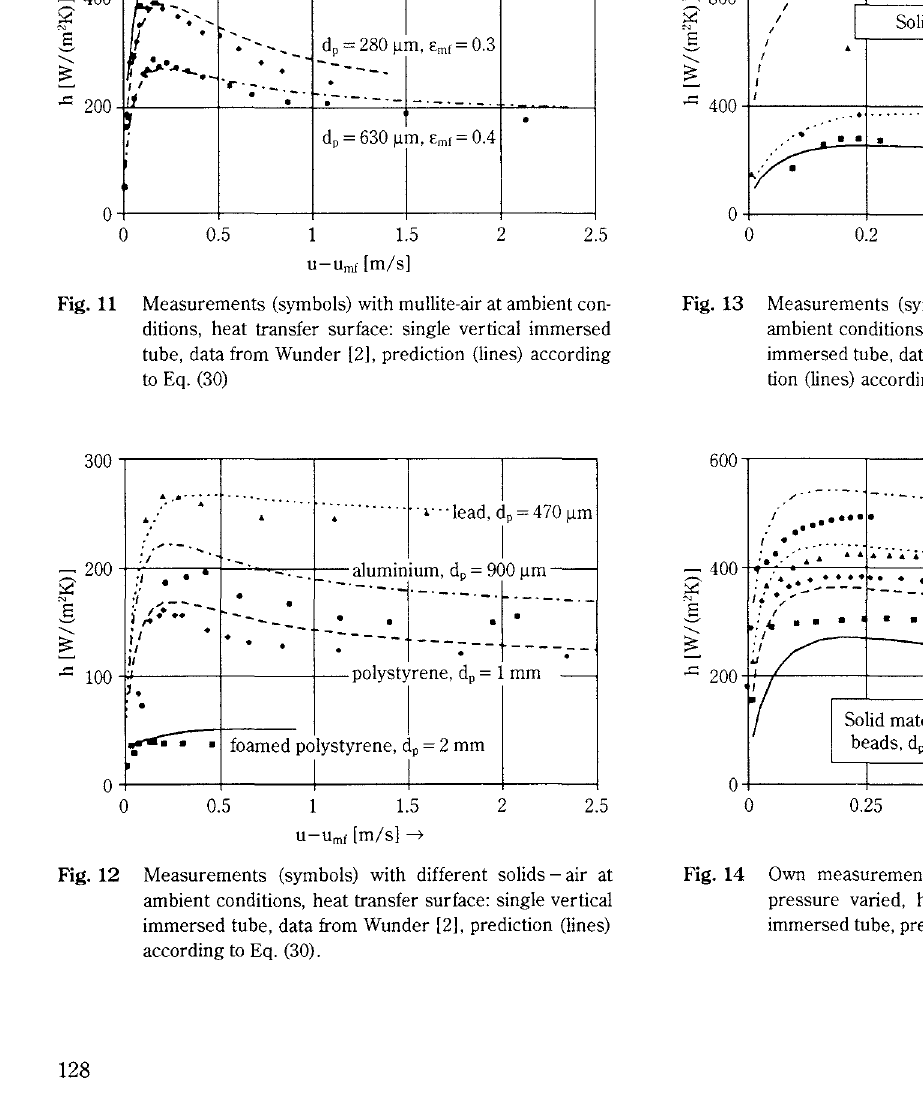
Fig. 12 Measurements (symbols) with different solids- air at ambient conditions, heat transfer surface: single vertical immersed tube, data from Wunder [2], prediction (lines) according to Eq. (30).